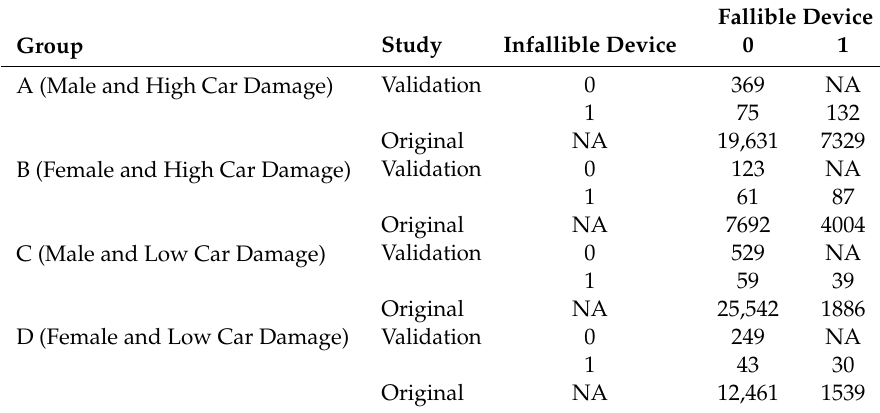
Table 3. North Carolina tra ffi c accident data.